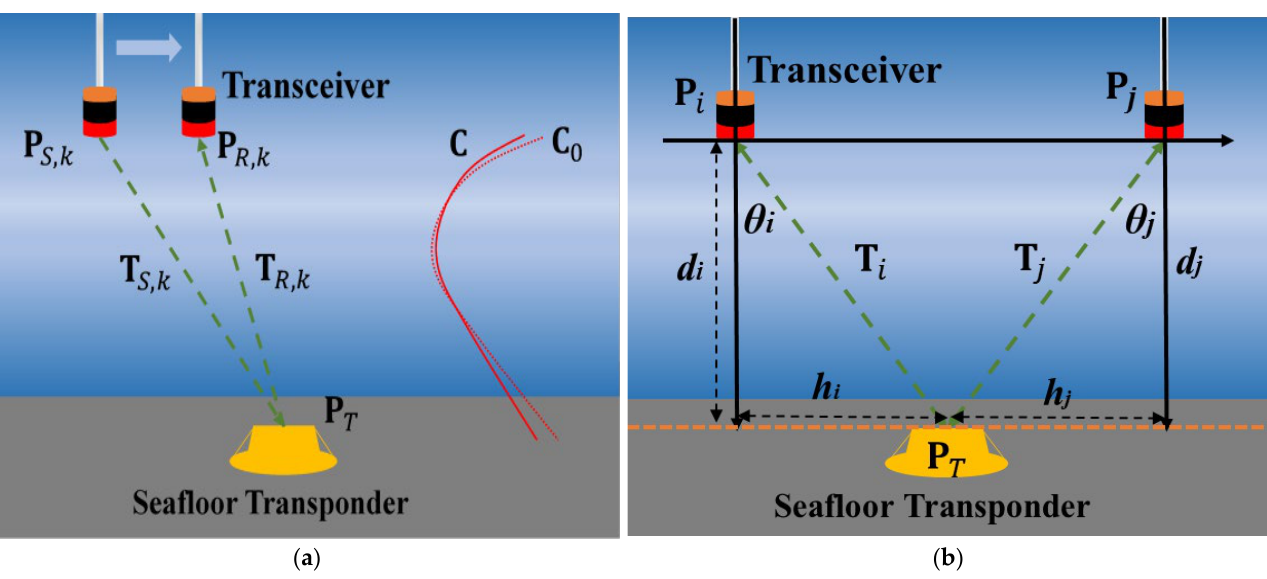
Figure 2. The round-trip acoustic travel time for one interrogation–reply cycle ( a ). The geometry scheme of transducer and transponder i and j stand for different observation cycles ( b